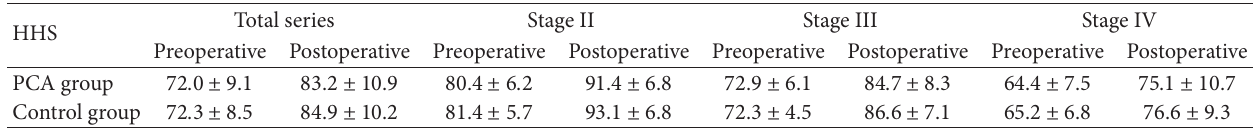
Table 2: Preoperative and postoperative Harris hip scores (HHS) in the postoperative corticosteroid administration group (PCA group) and the control group.